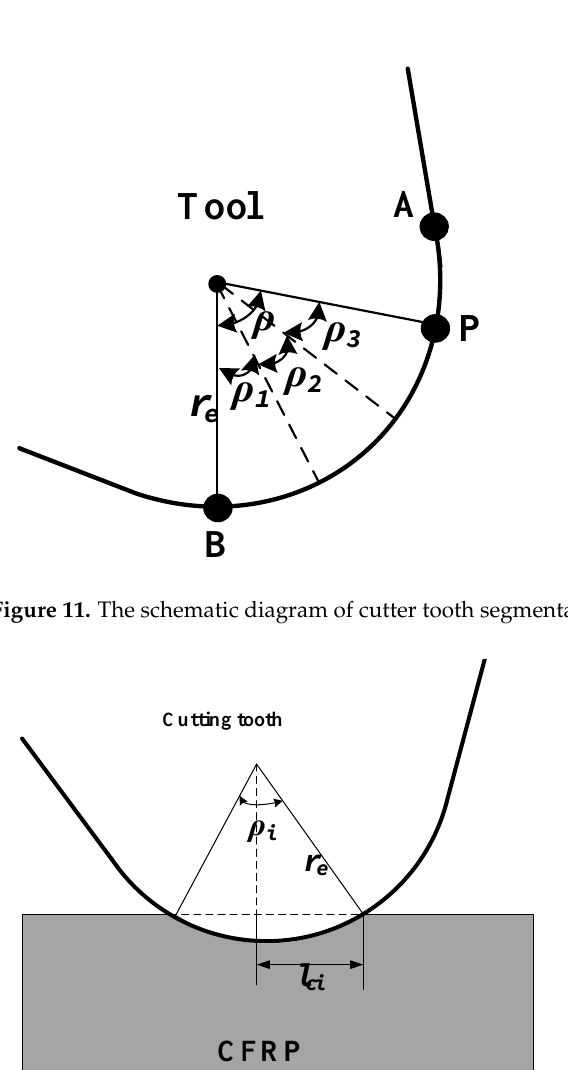
Figure 12. The schematic diagram of single-stage compression of cutter teeth. The schematic diagram of the positive pressure of the cutter tooth is shown in Figure 13. In order to facilitate the calculation, the force on each segment of the cutter tooth is treated as the concentrated force acting on the midpoint K i . The cutting force components per segment F 2.2 i in the x- and y -directions are defined considering the effect of the CFRP friction force on the cutter